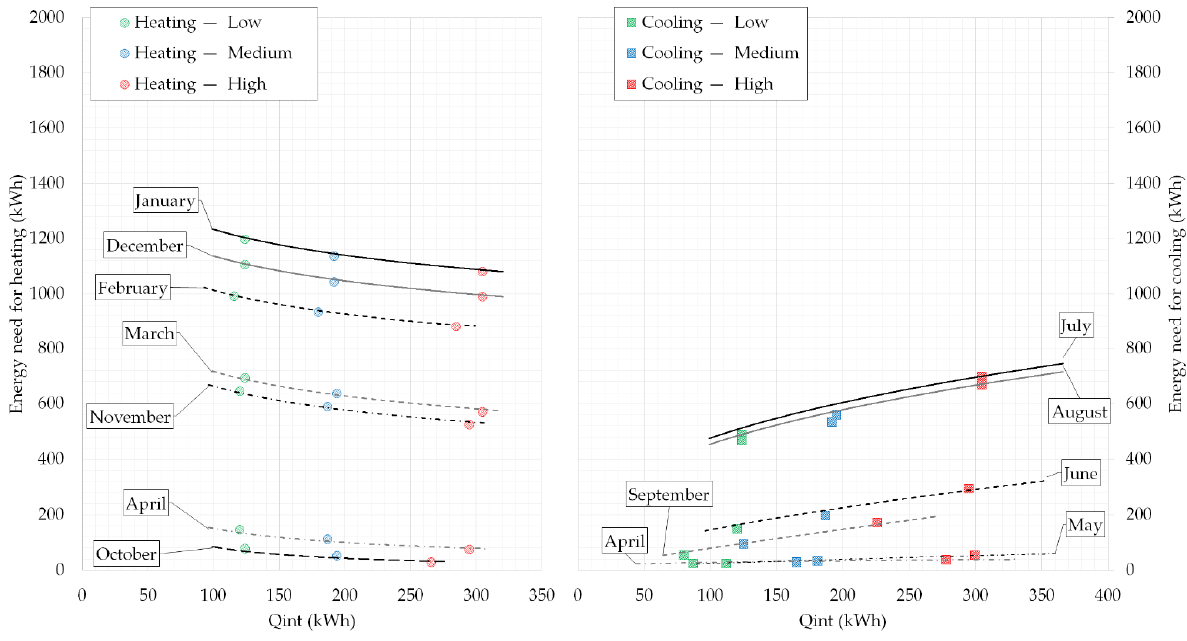
Figure 12. Heating and cooling energy needs as functions of the indoor thermal loads due to the individuals in the three scenarios.